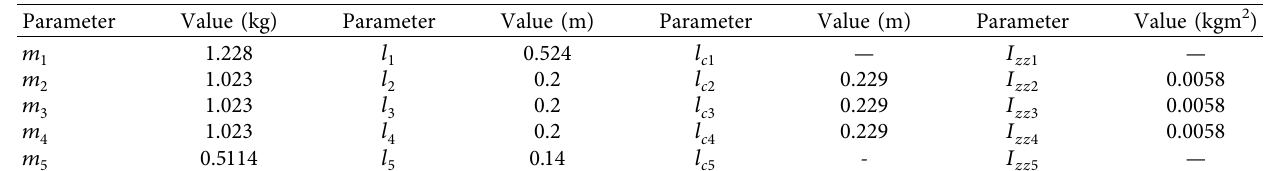
Figure 5: Computed-torque control scheme for trajectory tracking control of the manipulator. Table 4: Parameters of the SCARA manipulator.